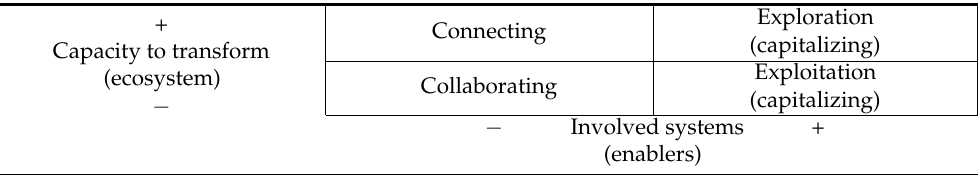
Table 5. Transformative role matrix for blockchain-based operations (adapted from [15,24,50]).